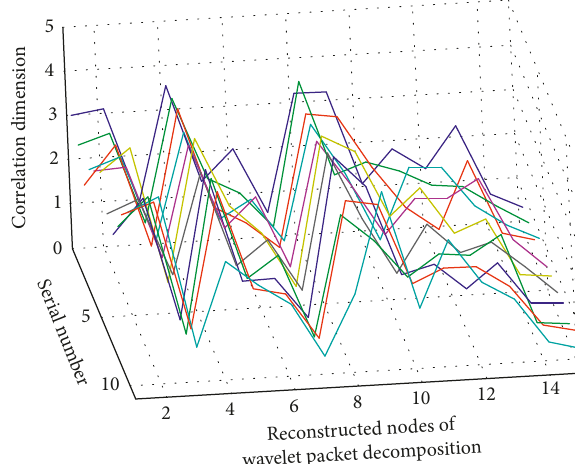
Figure 19: Correlation dimension spectra (1500r/min).